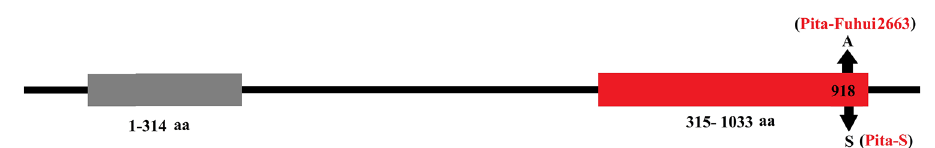
Figure 3. Structure comparison between Pita-Fuhui2663 and Pita-S. DNA sequencing analysis showed that there was only one amino acid substitution (A918S) between Pita-Fuhui2663 and